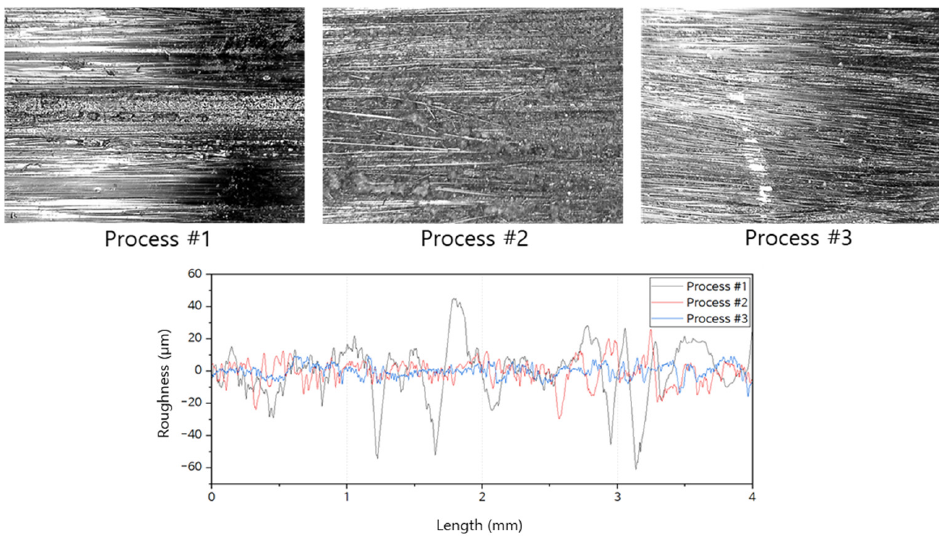
Figure 9. Surface images ( top ) and surface roughness curve in the transverse direction ( bottom ) of the CFRP bar produced in each process. Table 4. Surface roughness (Ra) in each process.